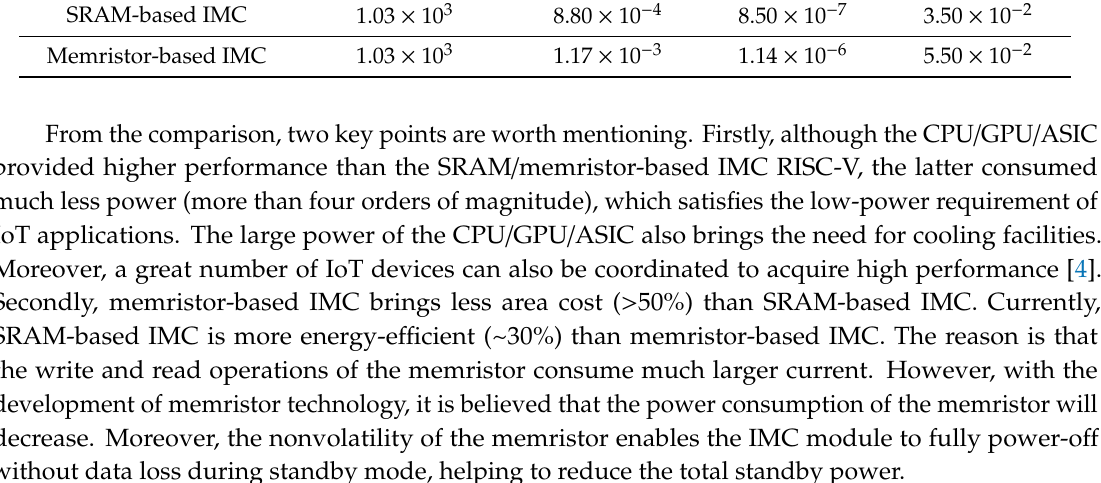
Figure 12. Comparison of energy consumption in overall Keccak process.